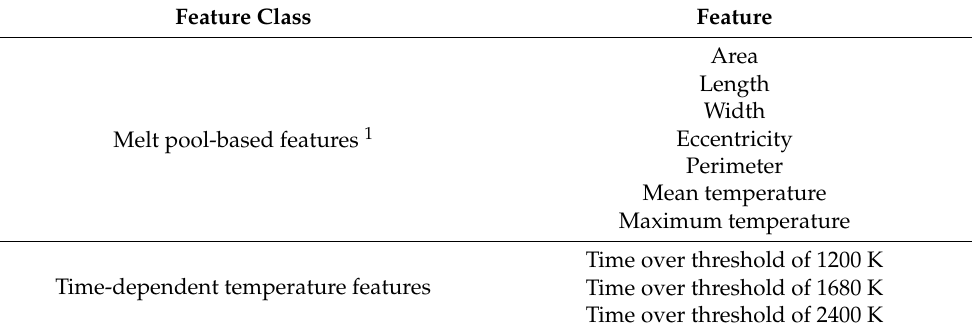
Table 2. Extracted features from in-situ monitoring